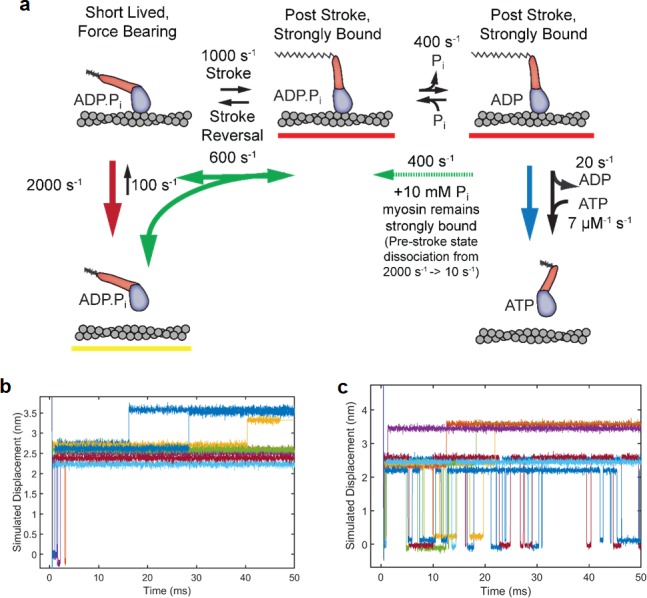
Simulations of ensembles averages with and without added Pi.The scheme in (a) is the same as text Figure 6, but with rate constants used in the ensemble average simulations shown in Figure 5g-h in the main text. The rate constants reflect the rates at 3pN of hindering load. The fast detachment rate of 2000 s−1, with a 1000 s−1 stroke rate leads to an observed stroke and detachment rate of 3000 s−1, similar to the observed rates at 3pN of load (Figure 2f, Figure 4c) and sets the fraction of short lived events near 60% (Figure 2—figure supplement 1). The stroke reversal rate of 600 s−1 corresponds approximately to the interpolated kint from the Bell equation fit in Figure 2—figure supplement 2b. The phosphate release and rebinding rates at 10 mM Pi were both set to 400 s−1 to recapitulate the ensemble average data, and are consistent with previous estimates of 600 s−1 and 400 s−1 respectively from muscle fiber experiments (Araujo and Walker, 1996). The rate of M·ADP·Pi binding to actin was set to 100 s−1 to produce an estimated ensemble rate of Pi release to be 18 s−1, in agreement biochemical findings (Rohde et al., 2017; Liu et al., 2015) (b) and (c) Examples of 8 individual traces simulated using the above pathway with added Gaussian noise. Averages of 450 such traces are shown in the main text Figure 5-g and h. (b) Traces simulated with no Pi rebinding and (c) simulated with Pi rebinding at 400 s−1, showing more reversals of the working stroke, especially those occurring later during the attachment.